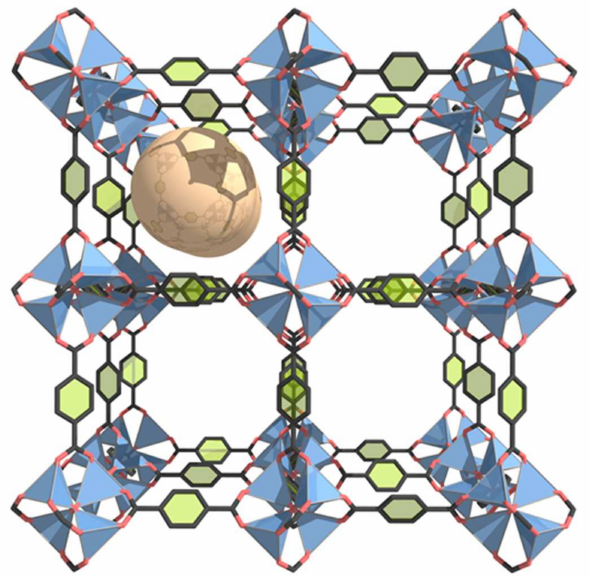
Figure 11. Crystal structure of IRMOF-1 (MOF-5), with the formula Zn 4 O(BDC) 3 , where BDC = 1,4-benzodicarboxylate, and blue tetrahedrons represent the Zn 4 O(-CO 2 ) 6 SBU from coordi- nation of BDC to the zinc center. (Oxygen; red, and black: